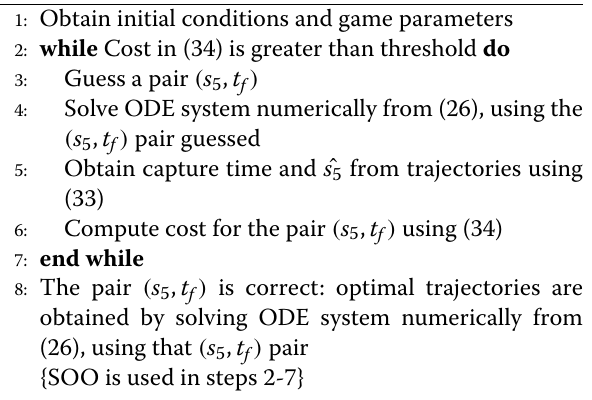
Algorithm 2 Steps for the optimization approach